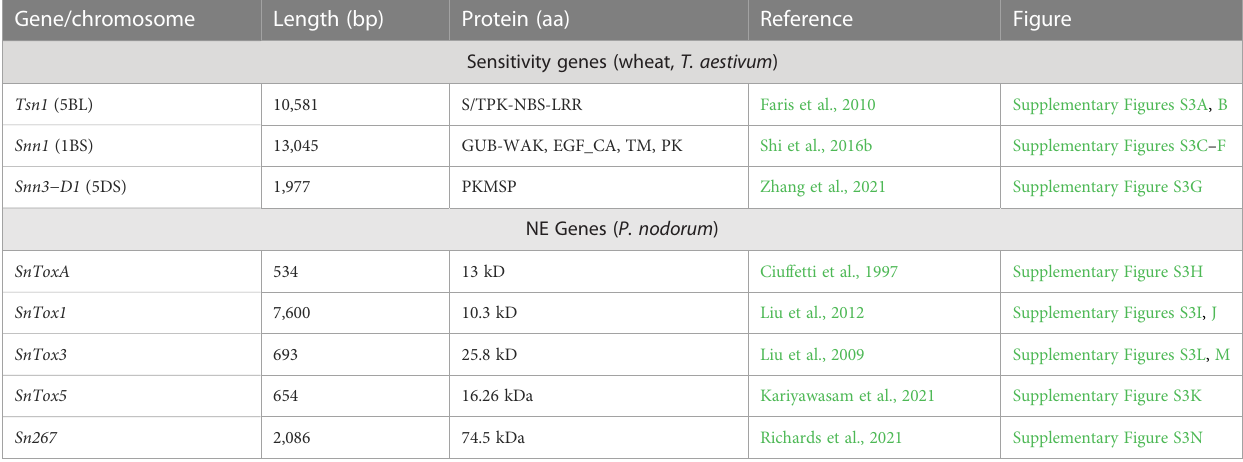
TABLE 4 A summary of cloned sensitivity and NE genes involved in SNB. Gene/chromosome